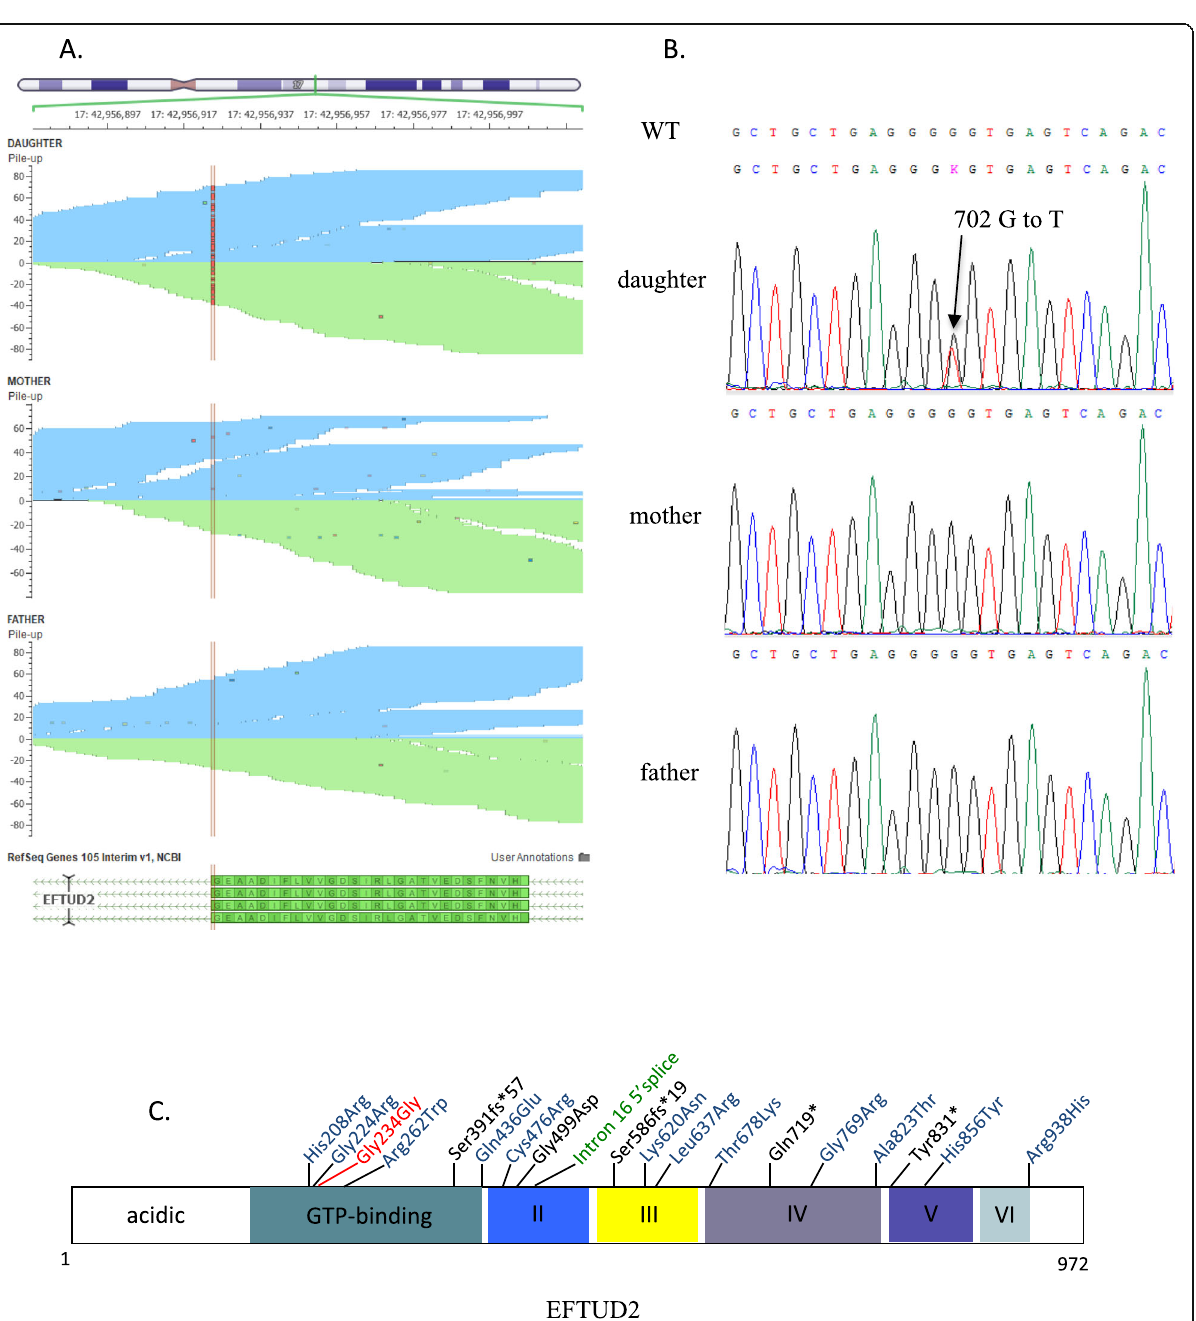
Fig. 1 Identification of the de novo variant in the patient. a The graphs present the Whole Exome Sequencing pile-up reads of the region of interest. The red lines highlight the identified de novo NM_004247.4 c.702G > T variant in EFTUD2 gene in the patient (Top graph) compared to its parent. b Electropherograms from Sanger sequencing of a nucleotide change from G to T in the proband (Daughter) compared to her parents. This variant is a heterozygous variant as both alleles harbor a different nucleotide. c Schematic view of EFTUD2 protein structure, with the location of c.702G > T, p.Gly234Gly and of some other variants of different types causing MFDM disease. The synonymous variant identified in our patient is in red, missense mutations are shown in blue, truncating (nonsense and frameshift) mutations are shown in black, and the intron splice donor mutation is shown in